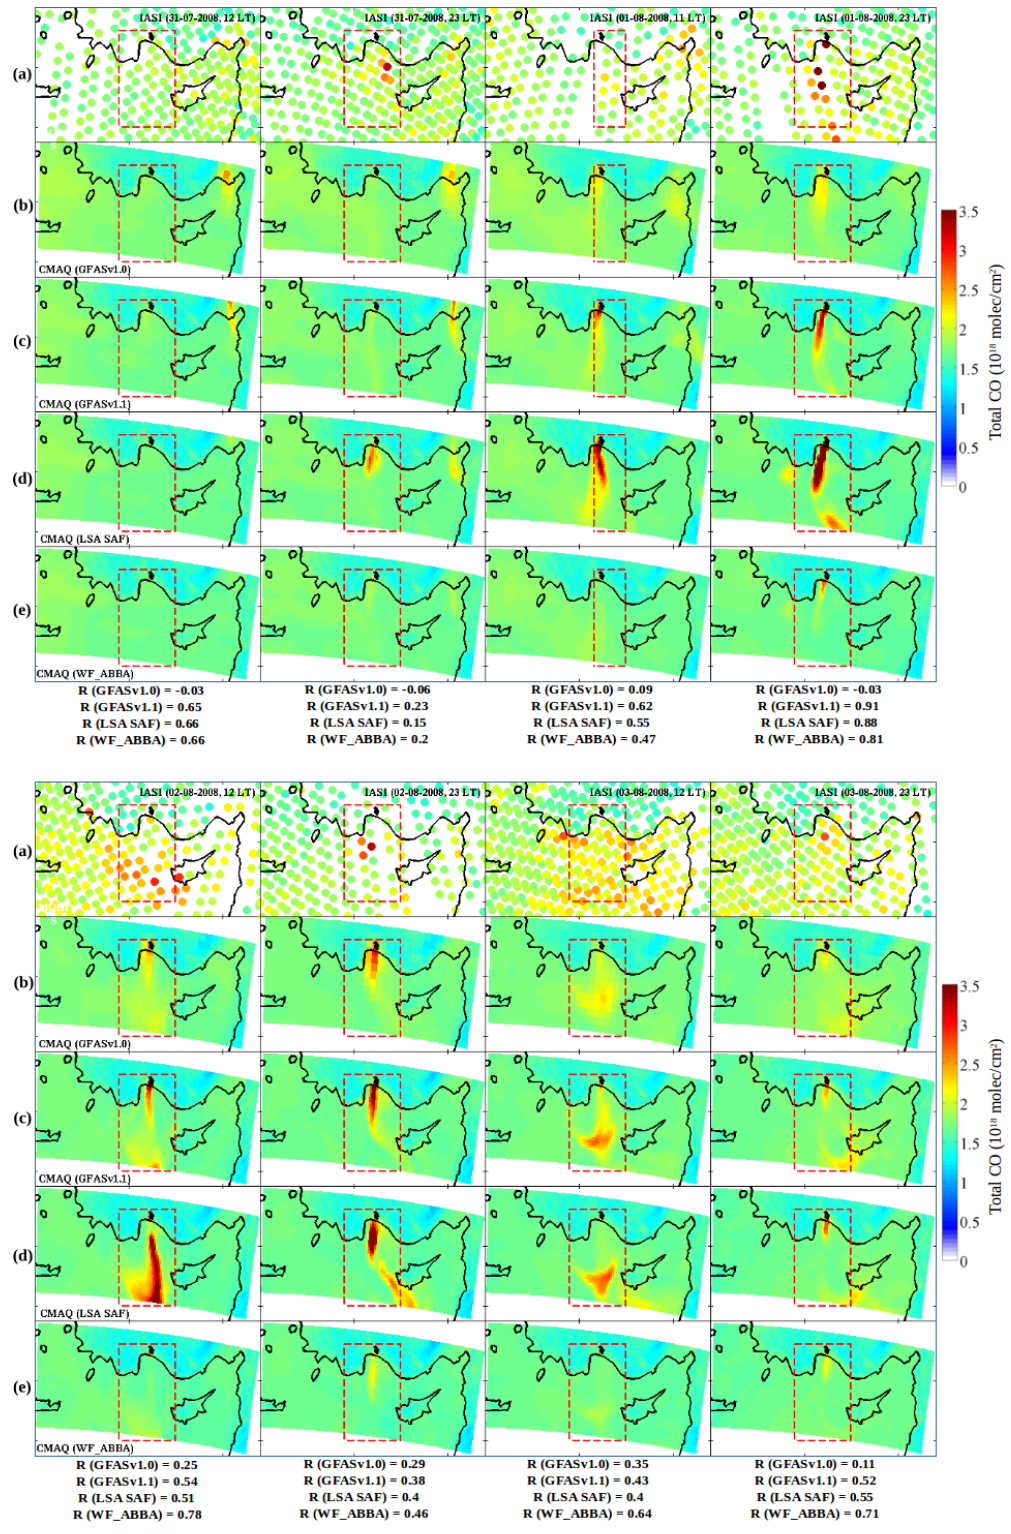
Figure 11. Daily AM and PM CO total column (moleccm − 2 ) from top to bottom, using IASI, CMAQ(GFAS1.1), CMAQ(LSA SAF) and CMAQ(WF_ABBA) between 31 July 2008 and 3 August 2008 over the area of study. Pearson’s R coefficients between IASI CO and CMAQ CO simulations are given